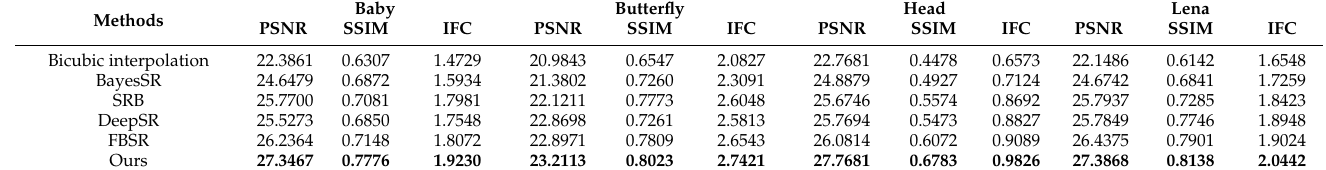
Table 1. PSNR, SSIM and IFC results of our algorithms on synthetic LR images when the magnification factor is 4.